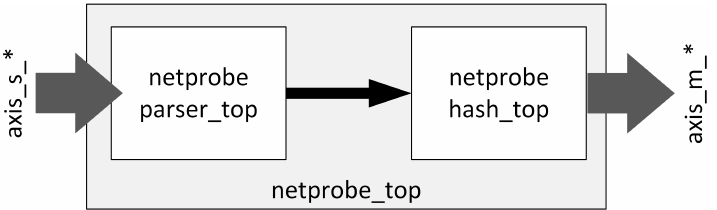
Figure 7. Block scheme of the network probe hardware accelerator’s top module— netprobe_top .